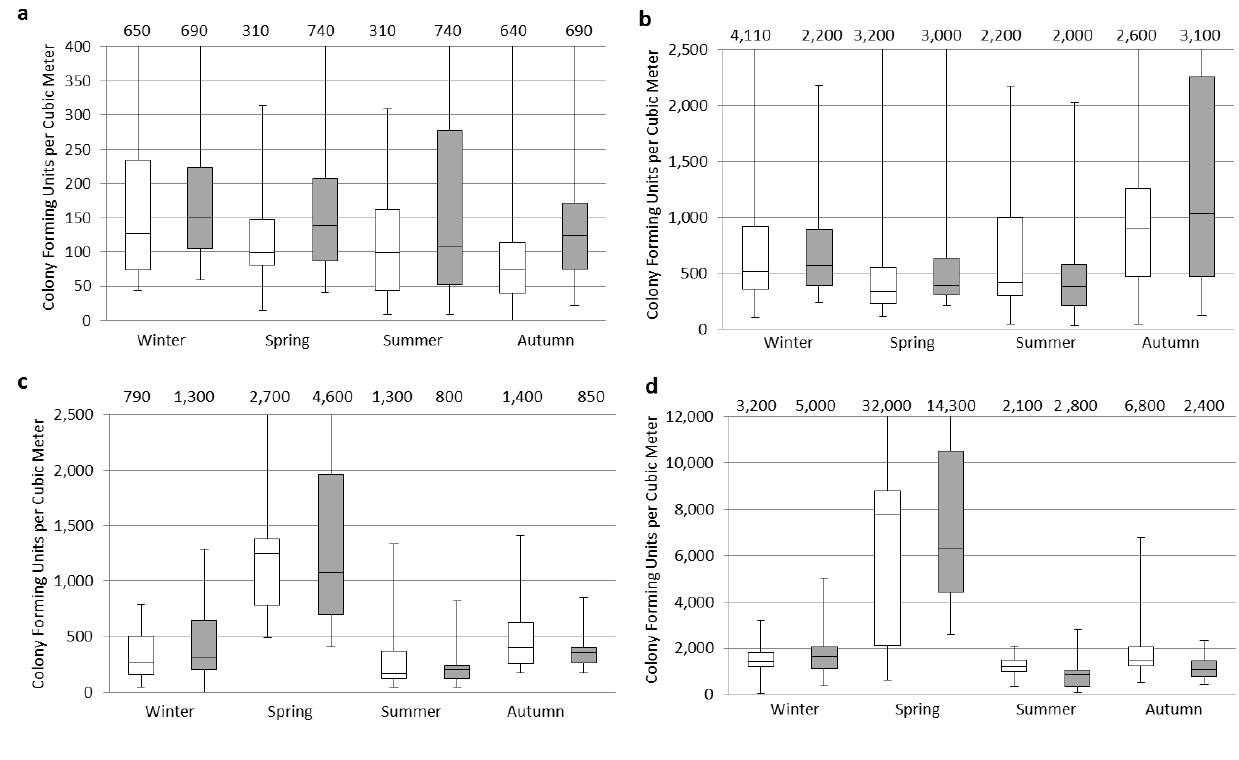
Figure 1. Culturable airborne fungal concentrations measured indoors and outdoors in the rural and urban sites in Egypt. The box plots represents indoors (white) and outdoors (grey) where: ( a ) Urban > 8 µm; ( b ) Urban < 8 µm; ( c ) Rural > 8 µm; and ( d ) Rural < 8 µm. Note: Y -axis is scaled differently in each